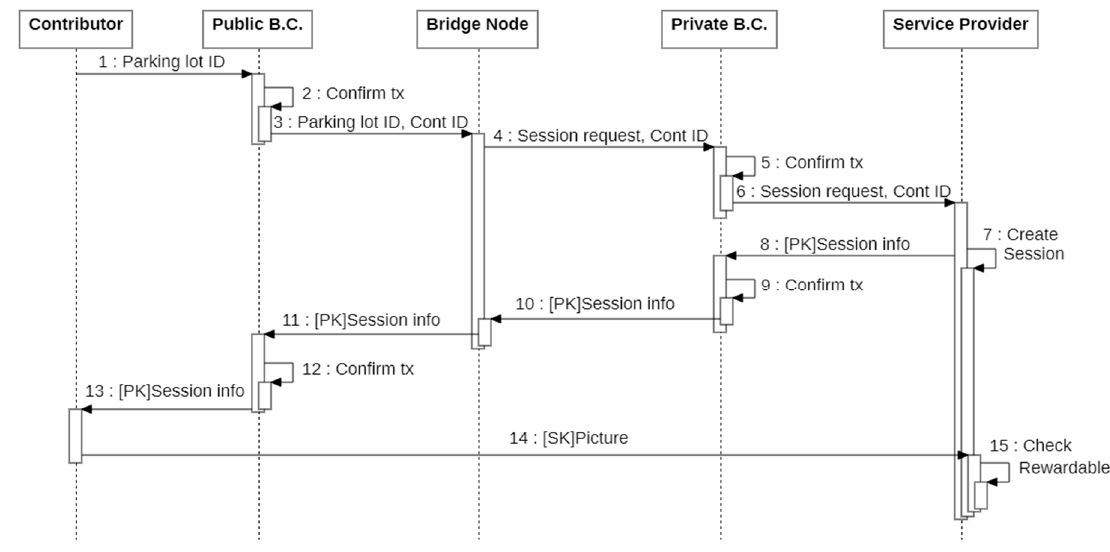
Figure 6. Sequence diagram for data contribution.